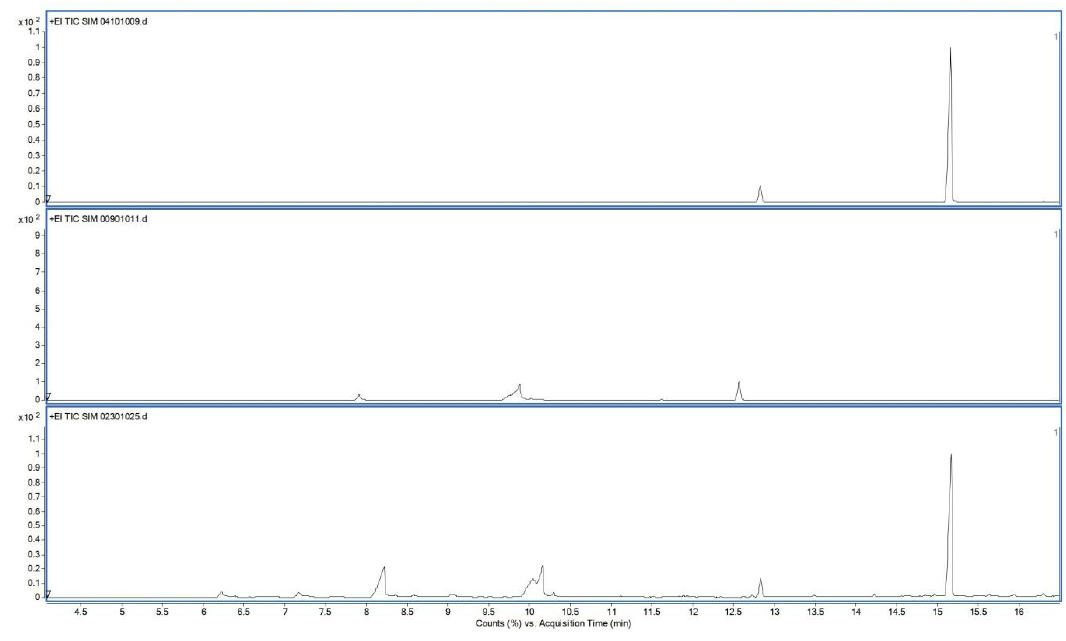
Figure 4. GC-SIM total ion chromatograms of reference solution ( top ), sample solution from unused wipe ( middle ) and sample solution from used wipe ( bottom ).